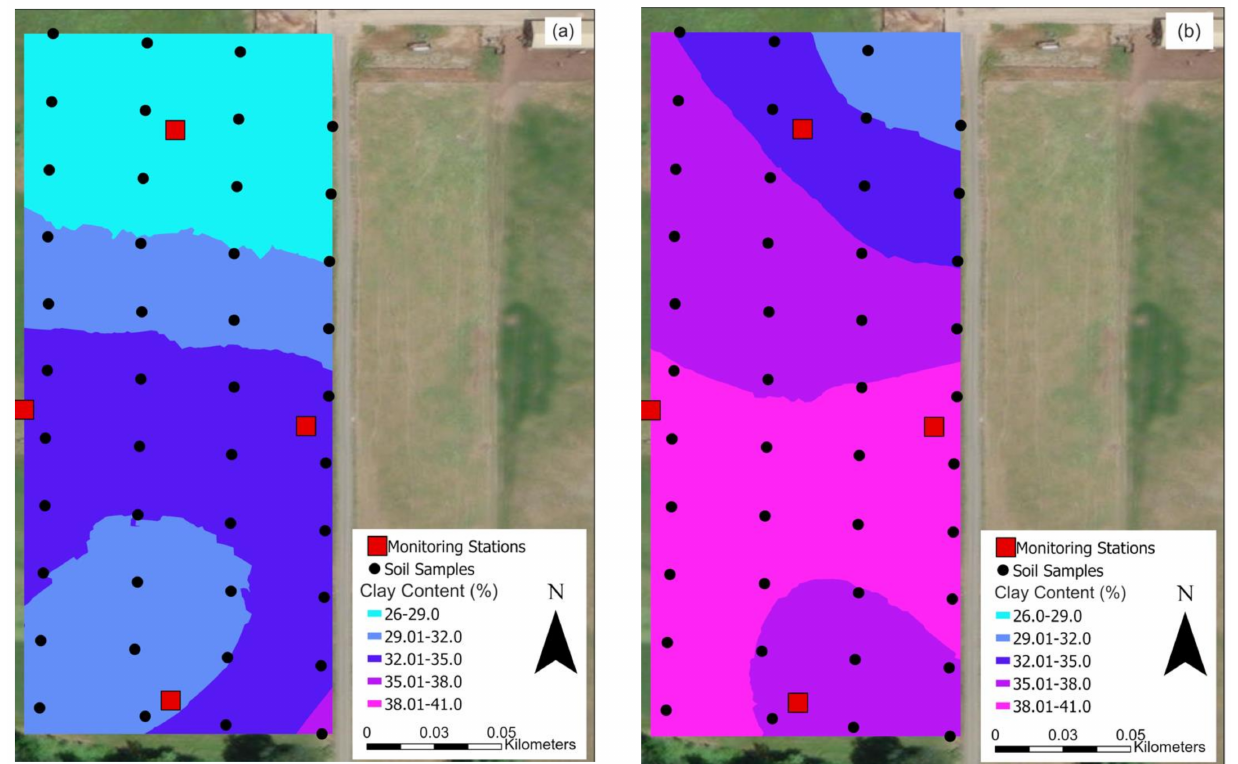
Figure 3. Clay distribution using data from the 43 soil samples and monitoring stations using Ordinary Kriging at the ( a ) 0.2 m depth and ( b ) 0.5 m